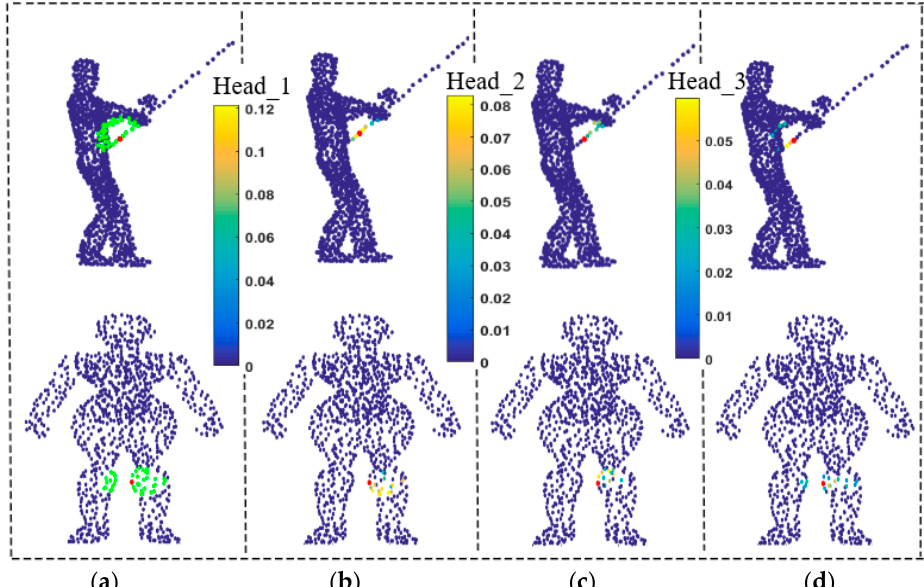
Figure 7. Neighborhood learning of multi-head structure under pathological conditions. ( a ) Two point cloud models. ( b ) The first head. ( c ) The second head. ( d ) The third head.